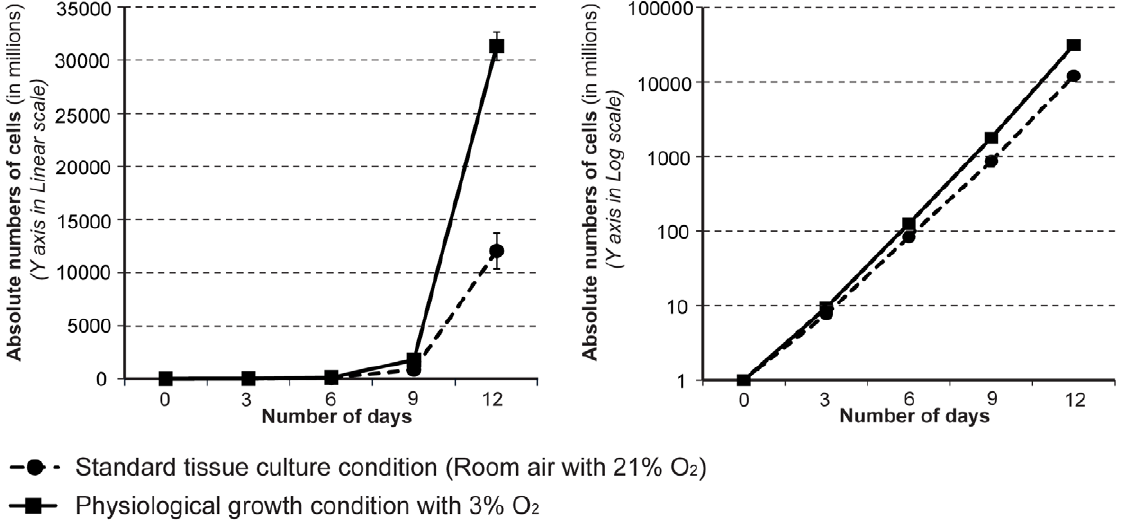
Figure 1. Cancer cell proliferation is markedly suppressed by the standard cell culture conditions used for invitro experiments. Equal numbers of A2780 ovarian cancer cells were seeded in a 10 cm petri dish and were routinely maintained under 3% O 2 (physiological) or 21% O 2 (ambient). The increase in cell numbers was determined by counting manually once in three days, and the total cell numbers were estimated and plotted using linear scale (in Graph A) and log scale (in Graph B).